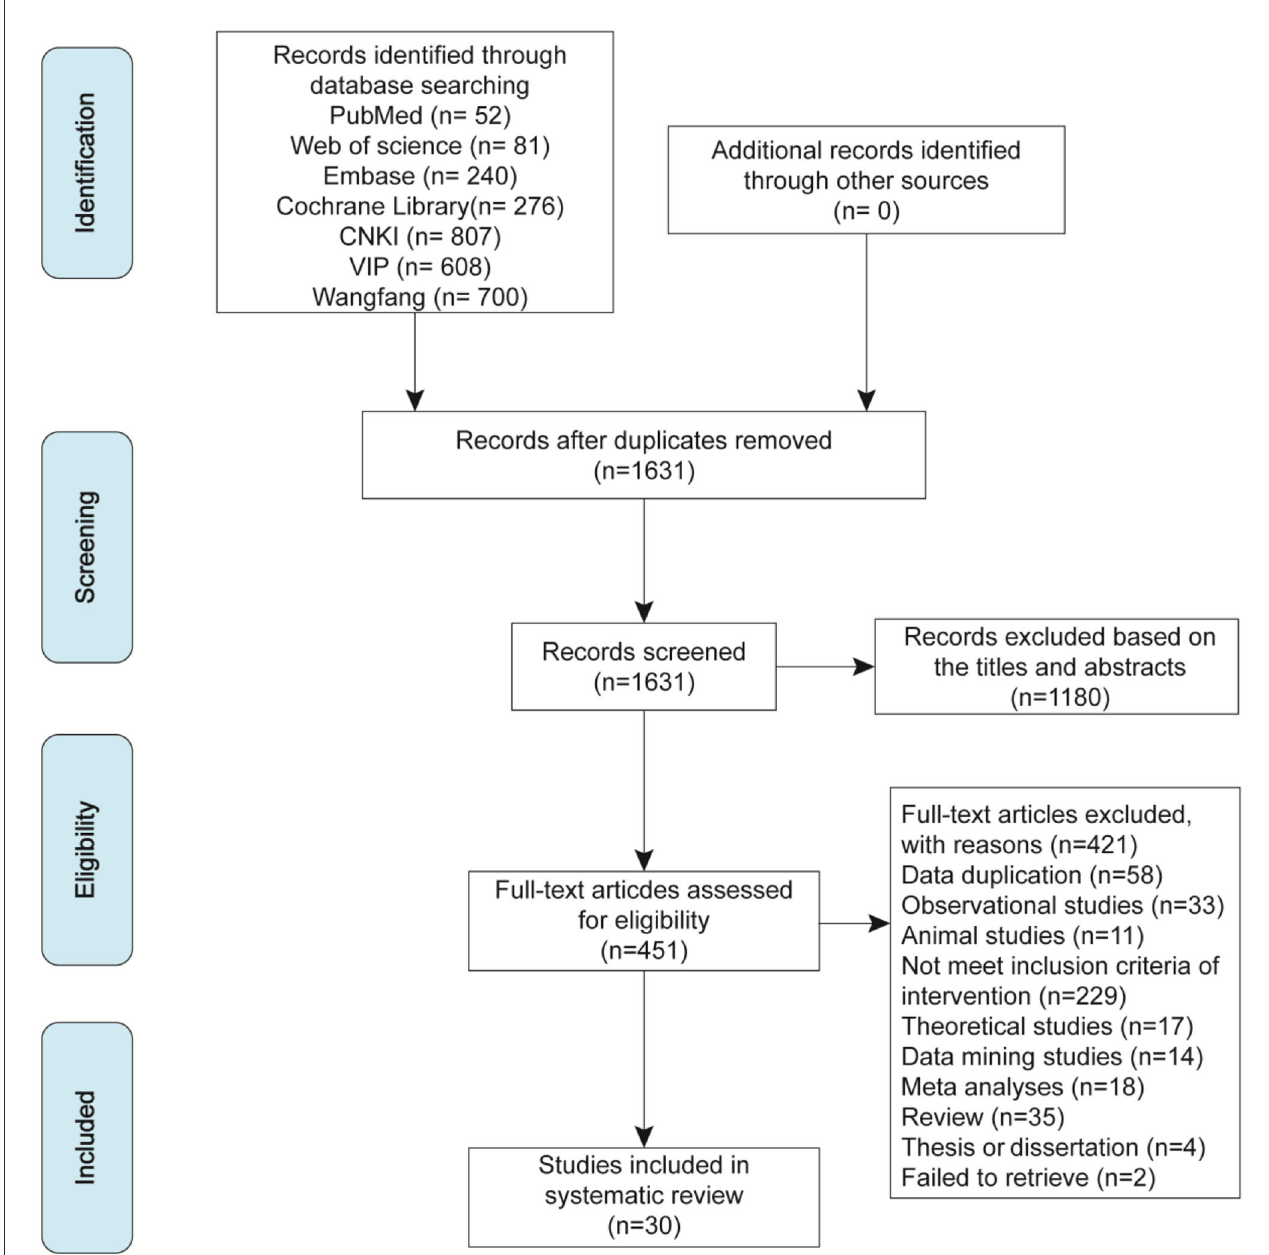
FIGURE1 The Preferred Reporting Items for Systematic Reviews and Meta-Analyses (PRISMA) flowchart of the literature search and